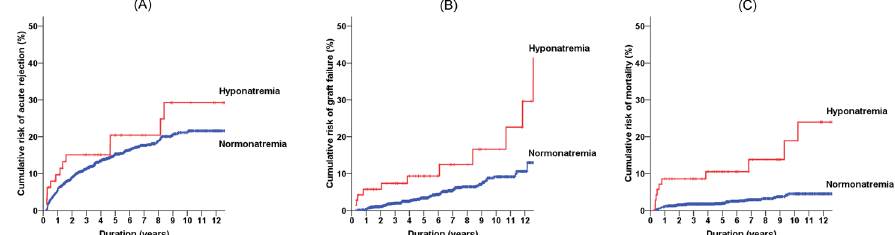
Fig 2. Kaplan-Meier curves for the cumulative risks of acute rejection (A), graft failure (B), and all-cause mortality